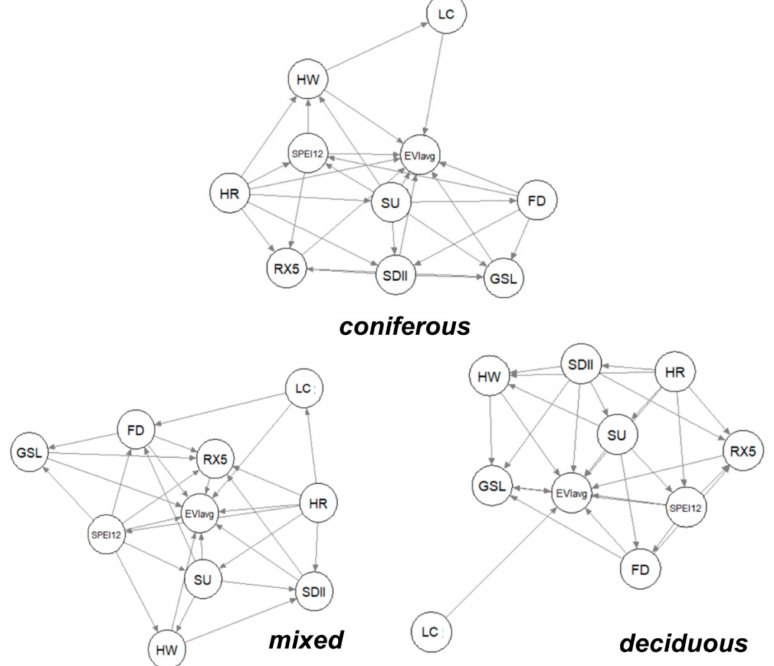
Figure 5. Identified causal network per vegetation type. The Bayesian network revealed the major causal linkages among the considered climate and human factors for coniferous, mixed, and deciduous forests: LC: Human-induced land cover change; FD: Frost days; GSL: Growing season length; HR: Precipitation over 80 mm; RX5: Maximum 5-day precipitation; SDII: Simple daily precipitation intensity;